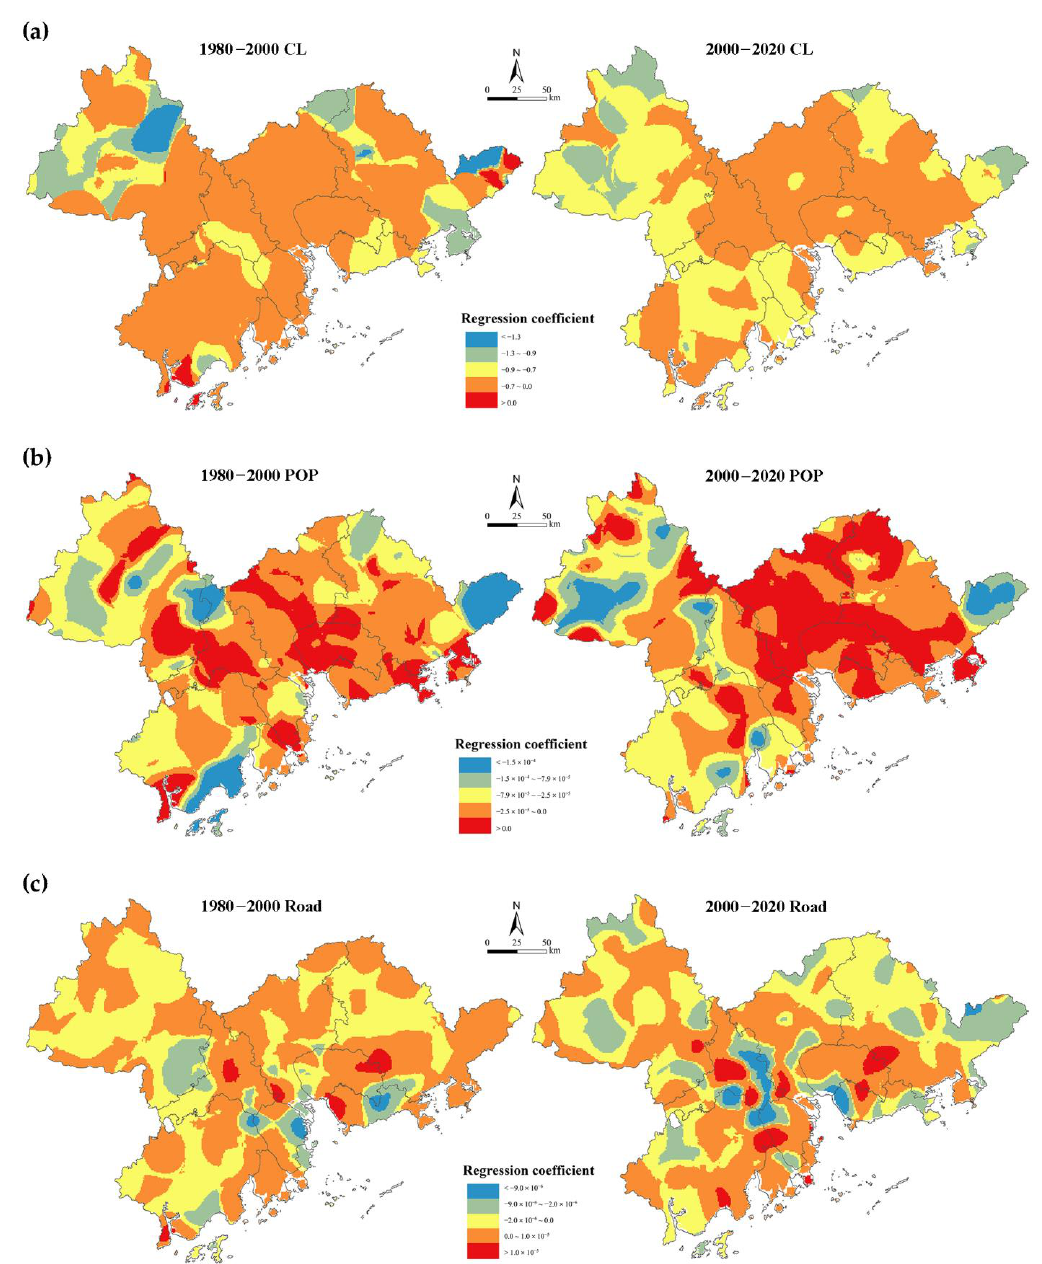
Figure 13. Spatial patterns of correlation between socioeconomic factors and habitat quality (POP: population).